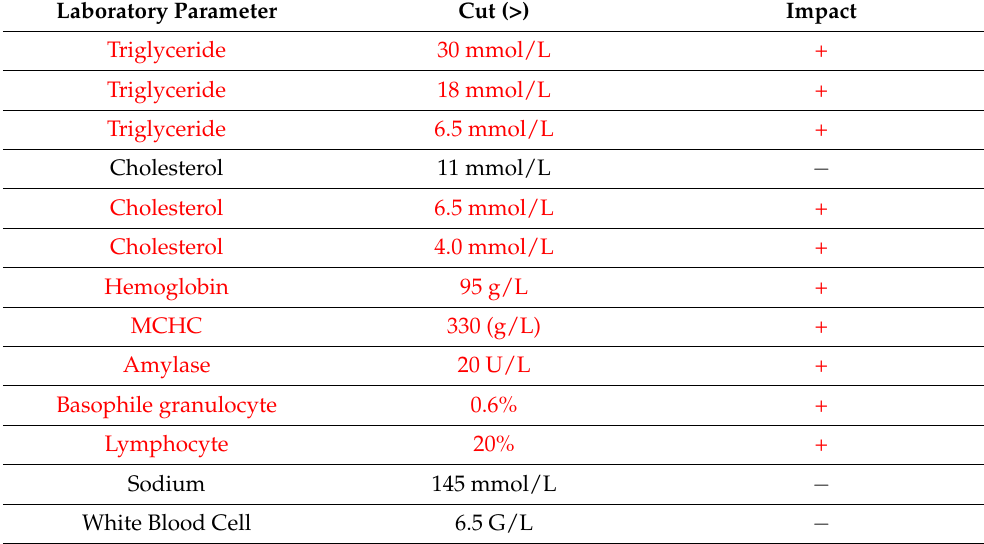
Table 7. Summary of the most decisive laboratory value cuts in machine learning models and their impact on getting closer to (+) or away ( − ) from likelihood of